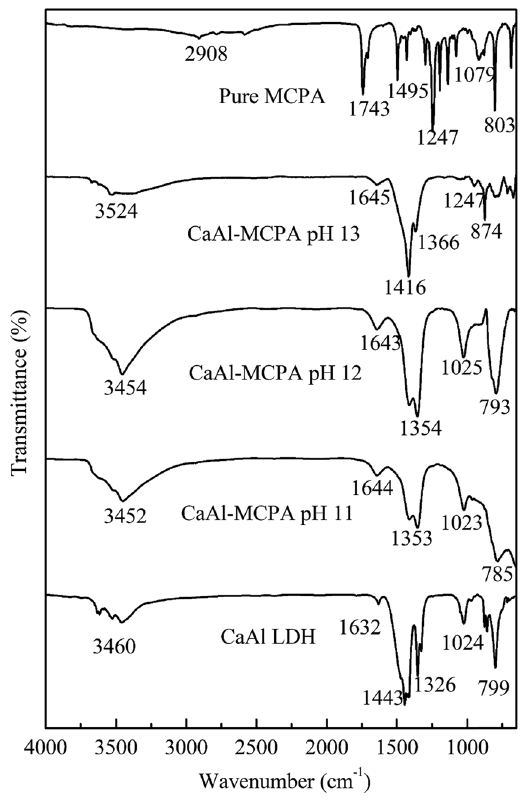
Figure 4: ATR - FTIR spectra of CaAl LDH host and its nanocomposites at various